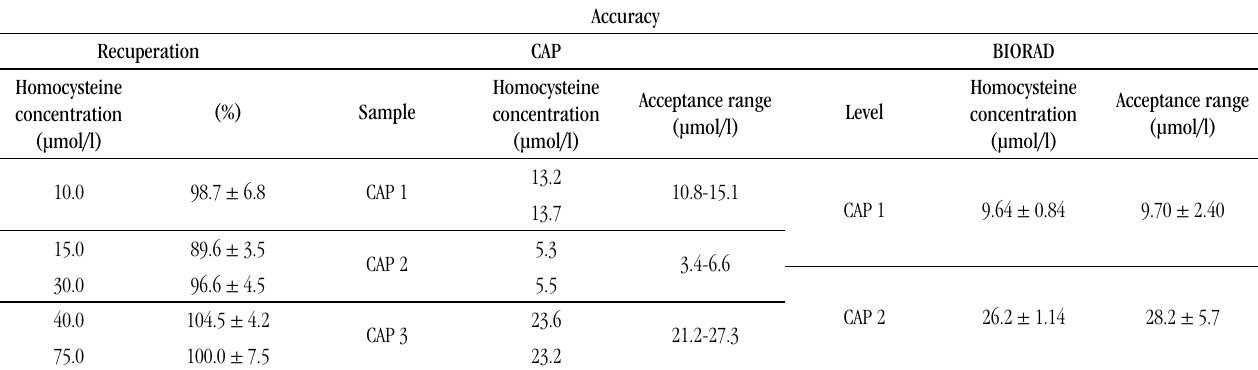
tABLE 3 − Evaluation of the accuracy of homocysteine by HPLC method, evaluated through method recovery, by CAP interlaboratory programme analysis and Biorad internal